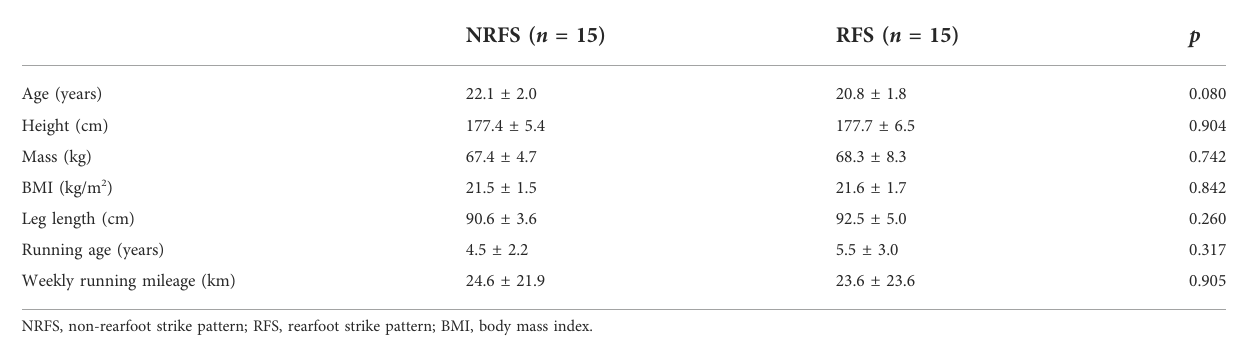
TABLE 1 Characteristics of participants.